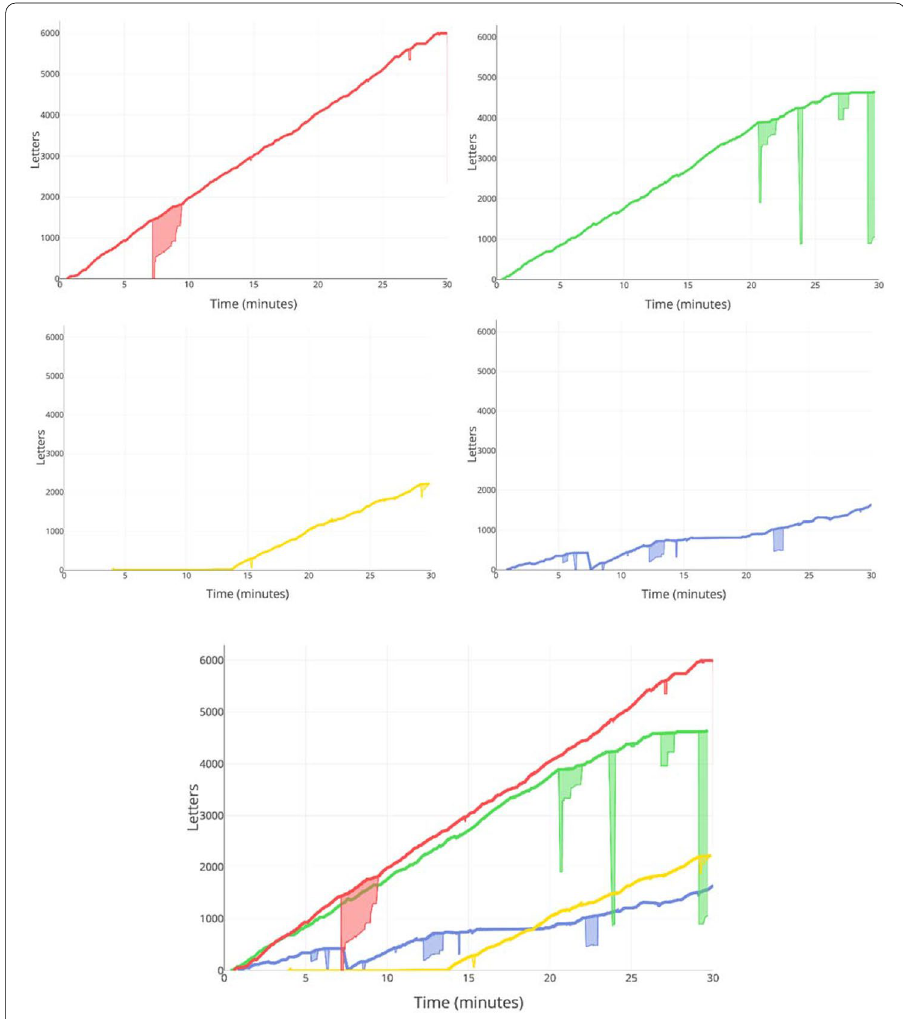
Fig. 2 Essay Length Plotted by Writing Time, Shown for Four Students Individually and Combined. The graphs plot process data from a NAEP 8th-grade writing assessment pilot study. The horizontal axis in each graph shows time elapsed, while the vertical axis shows the number of characters typed by a student. The slope shows the speed at which a student composes the written response to the test prompt. The first student (shown in red) composes the response at a pretty steady rate with only one moment of deleting and rewriting. The second student (shown in green) has a slower rate and three episodes of significant deleting and rewriting. The third student (shown in yellow) spends almost half the response time without typing anything and then writes at a steady rate to the end of the time period. The total amount composed is markedly less than the first two students, indicated by the lower level reached on the vertical axis. This student has no episodes of significant deleting and rewriting. The last two show a slower rate of composition and again an overall lower level reached on the vertical axis indicating a much shorter response than the first two students. The fourth student (shown in blue) has no major episodes of deleting and rewriting but has some minor deletions and rewriting. If all student responses are combined on a single graph, we can see that they represent markedly different patterns and amounts of writing. From the National Assessment of Educational Progress (NAEP) 2016 8th-grade writing assessment pilot